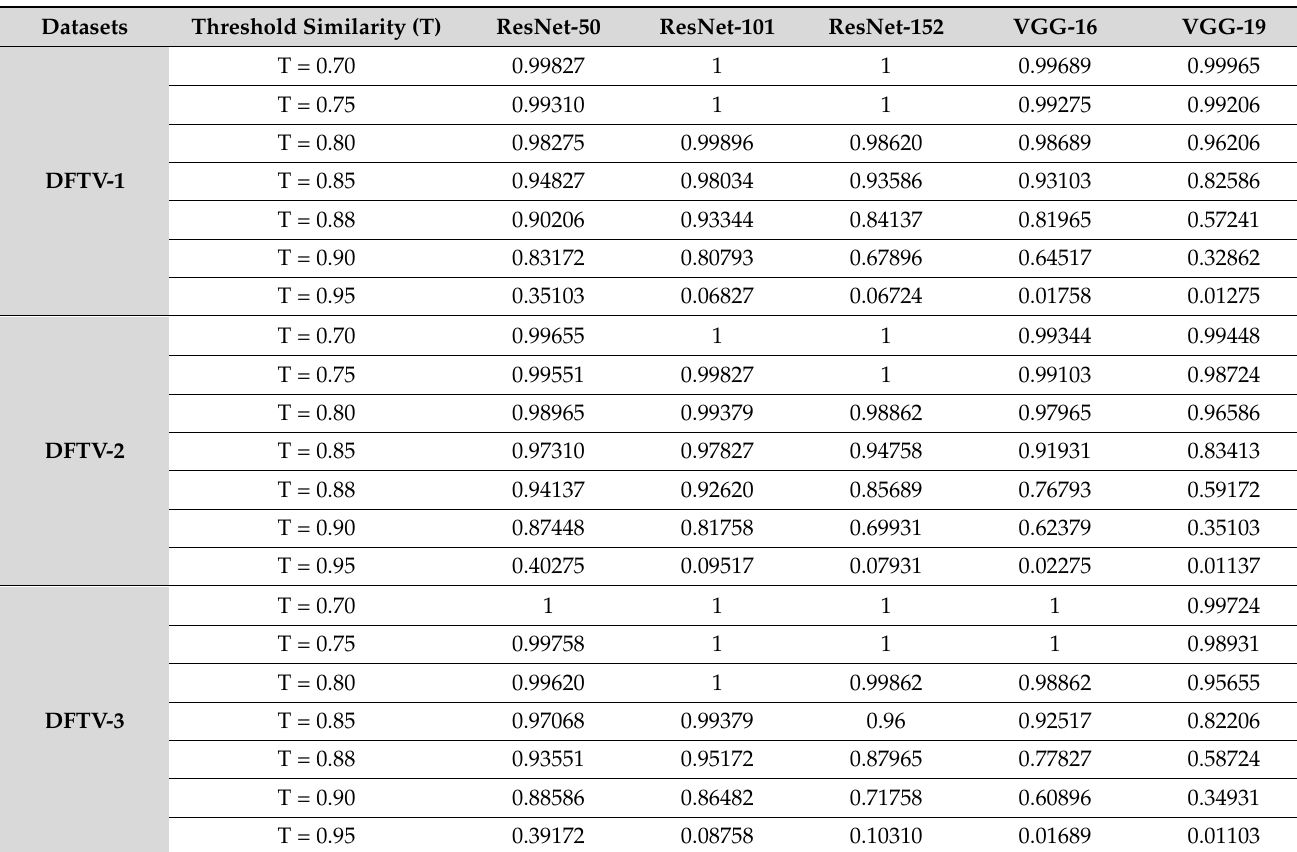
Table A4. Mean average precision (MAP) @ K = 10 of CNN